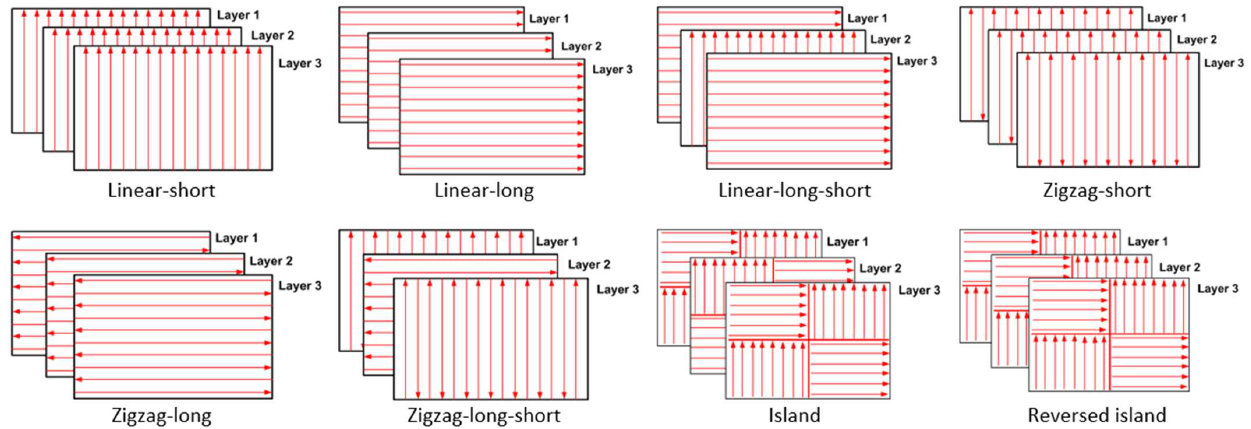
Figure 5. Build orientations used in this study.